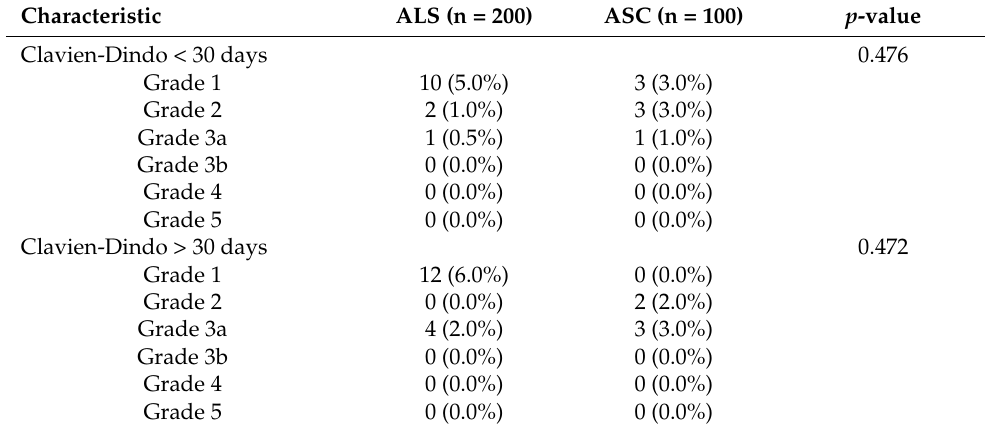
Table 6. Post-operative complications. Data are presented as n (%). Characteristics comparing ALS vs. ASC after surgery were statistically analyzed with two-tailed Fisher’s exact. p -values < 0.05 were considered statistically significant. ALS: Abdominal Lateral Suspension; ASC: Abdominal Sacral